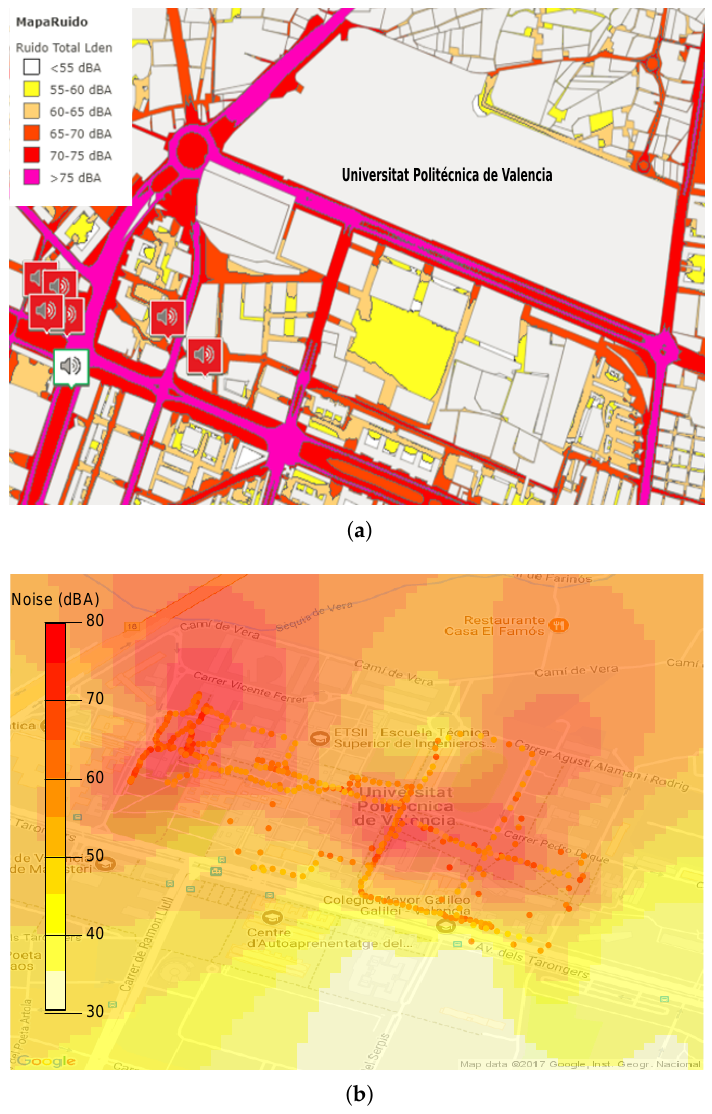
Figure 14. Comparison of the distribution of environmental noise according to official data and using our architecture. ( a ) Analysis of the noise distribution by the city council; ( b ) Analysis of the noise distribution by our proposed